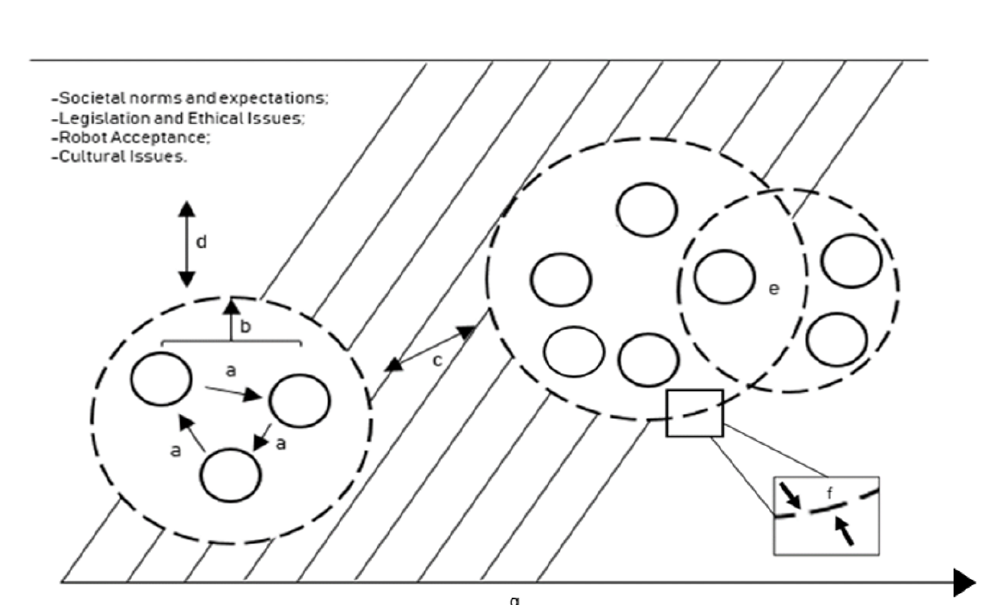
Figure 5. Schematic representation of the complexity and different relational levels of group interac- tions, including ( a ) interactions between members of a group, ( b ) interaction between a group and its members; ( c ) intergroup interactions; ( d ) relationship between the group and the wider social environment; ( e ) overlapping group membership; ( f ) representation of the fuzzy boundaries of social groups and ( g ) the progress in time of group